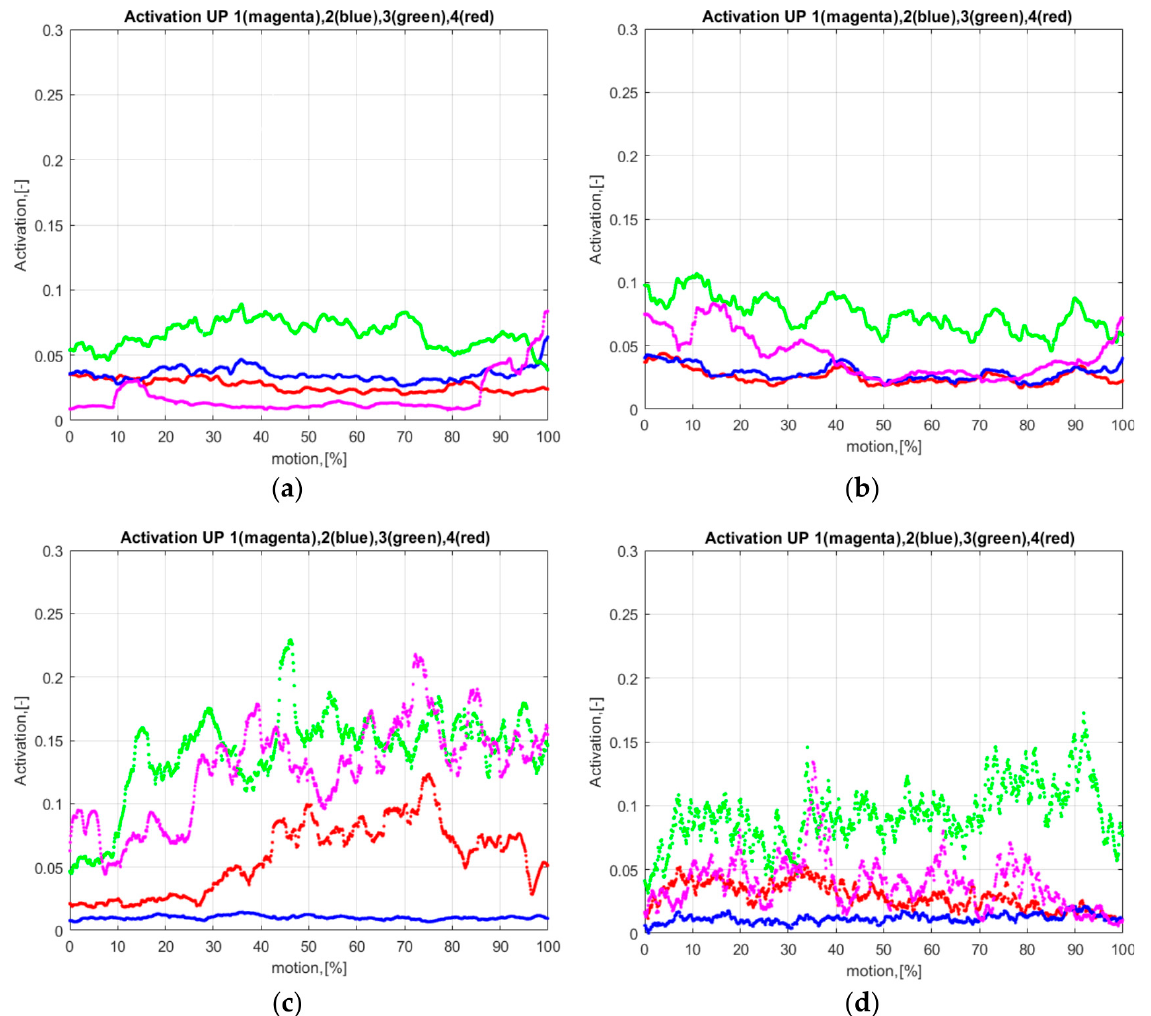
Figure 4. EMG data processed (mean value of the RMS normalized data): BB (EMG 1 ), TB (EMG 2 ), AD (EMG 3 ), and UT (EMG 4 ): ( a ) Reference subject in motion1 under natural conditions; ( b )